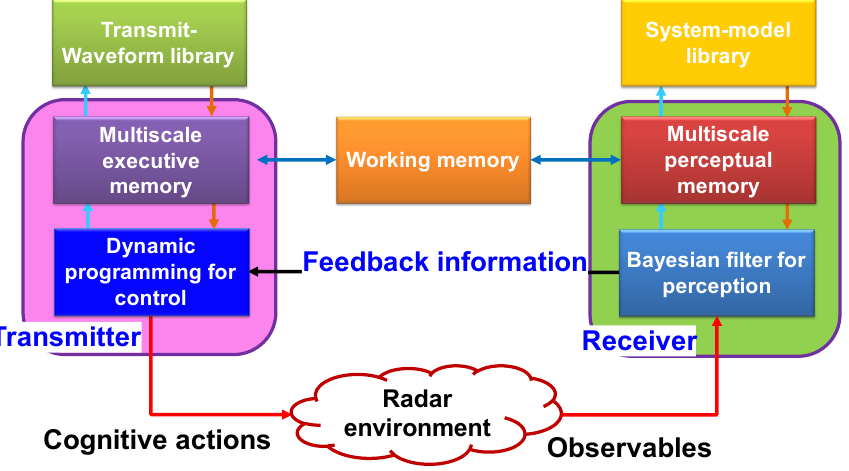
Figure 9. Block diagram of CR with memory.